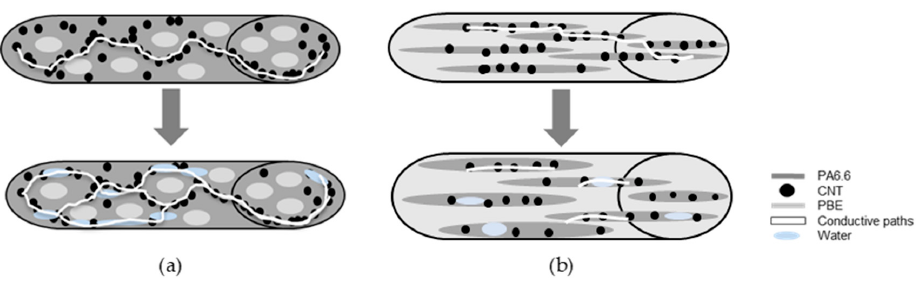
Figure 9. Hypotheses of the water detector monofilament: with a positive sensitivity ( a ), with a negative sensitivity ( b ).